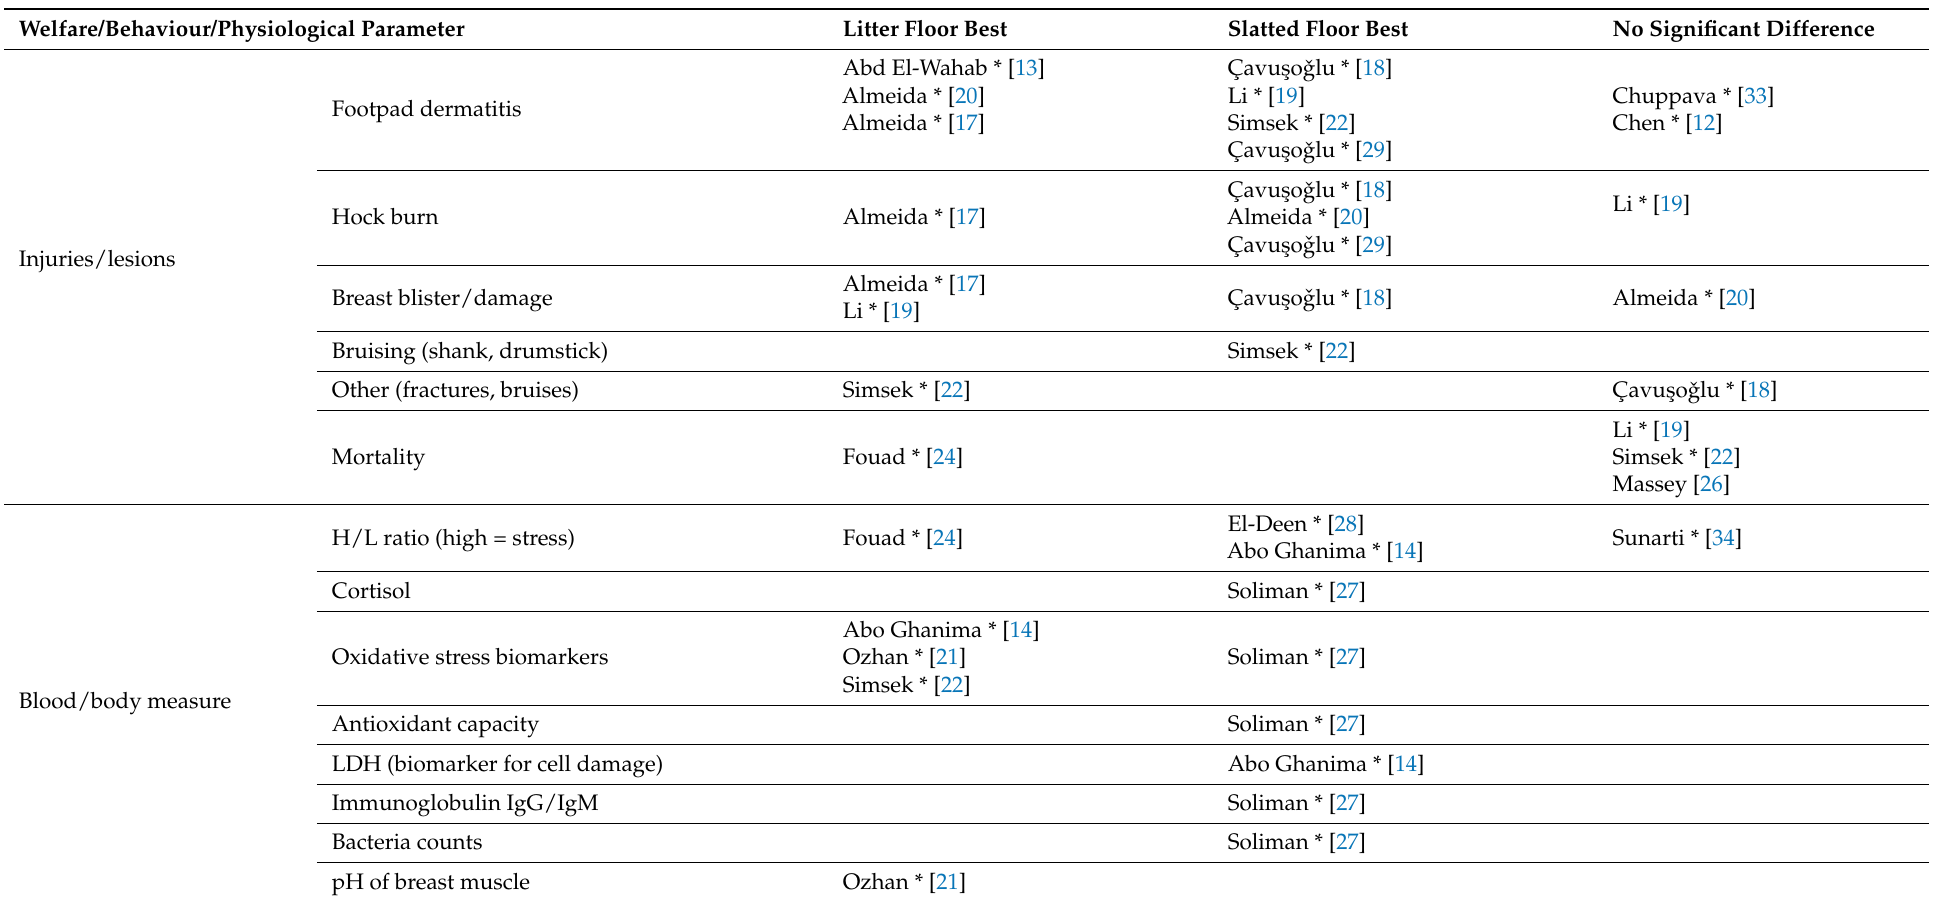
Table 3. Welfare indicators assessed in the papers in Tables 1 and 2. Nb: Performance/productivity indicators are excluded. Stars after names signify ‘et al.’. Some studies appear in more than one row or